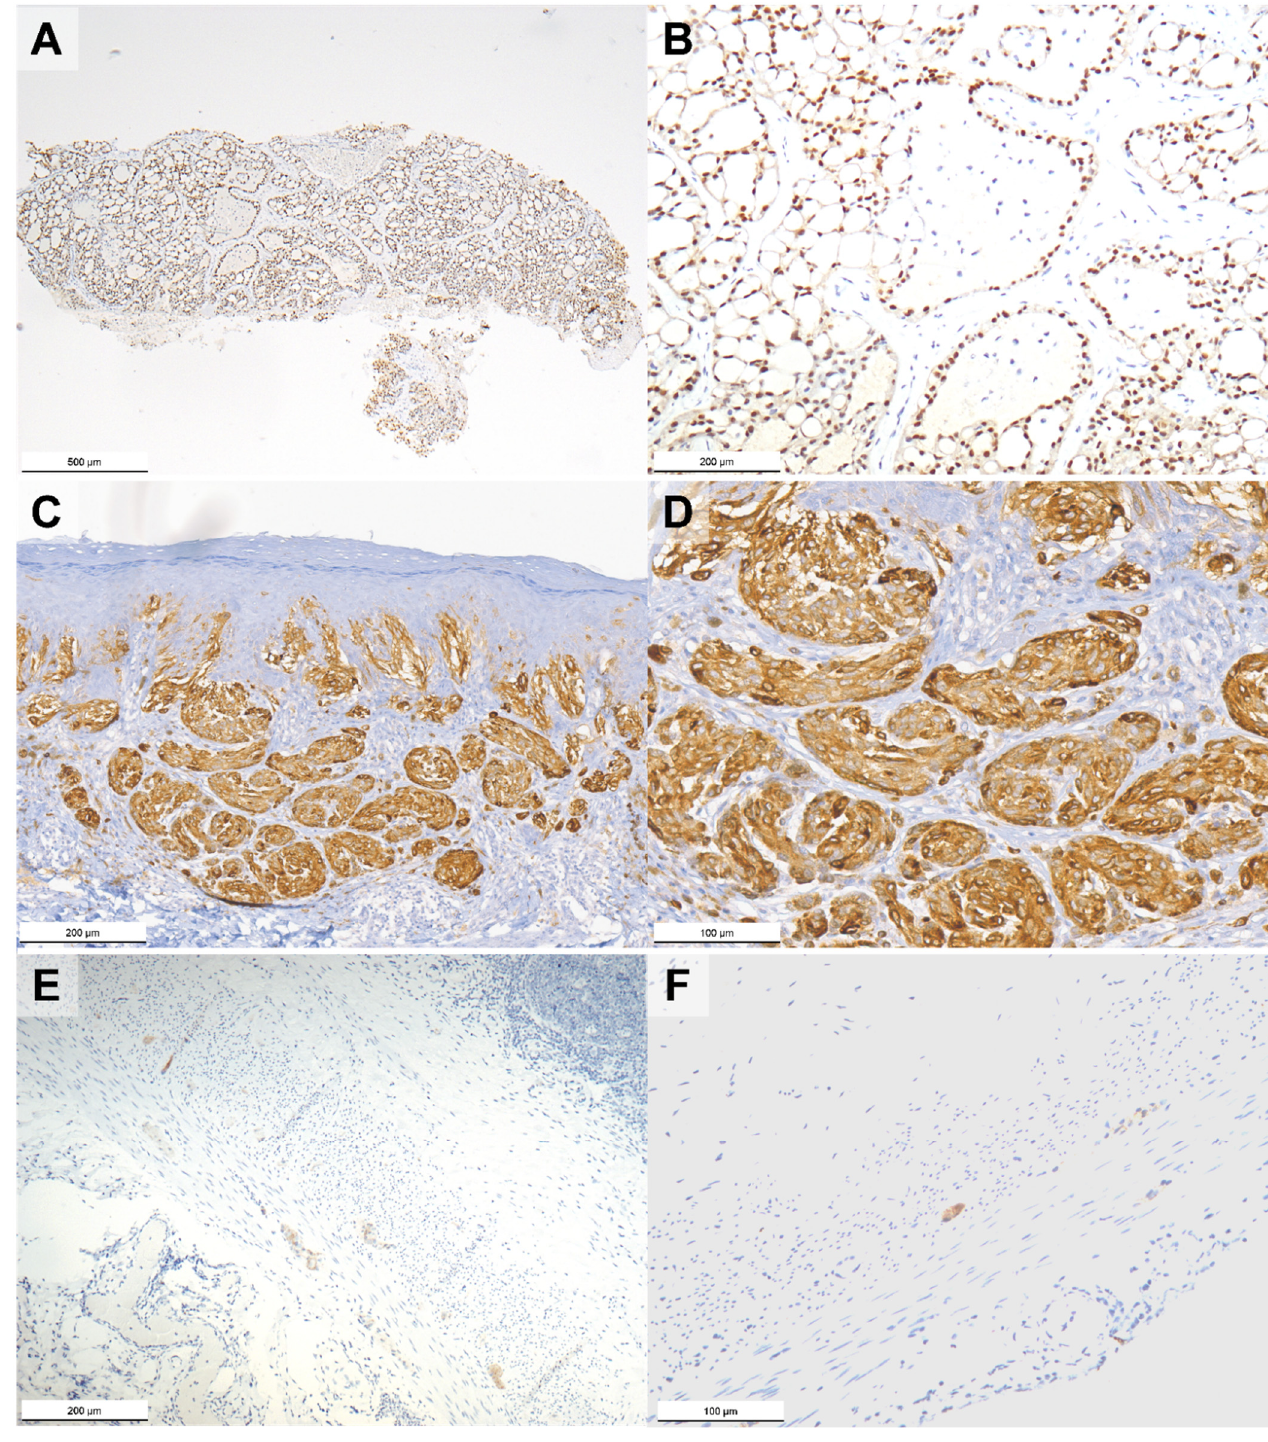
Figure 3. Photomicrographs of pan-TRK immunostained breast secretory carcinoma with known ETV6-NTRK3 fusion ( A , B ) showing nuclear immunoreaction, atypical Spitz tumor with known LMNA-NTRK1 fusion ( C , D ) showing cytoplasmic immunoreaction, and normal vermiform appendix without NTRK1 , NTRK2 , and NTRK3 fusions ( E , F ) showing cytoplasmic immunoreaction in the ganglion cells within the muscular layer. Original magnification 40× ( A ), 100× ( B , C , E ), and 200× ( D , F ).